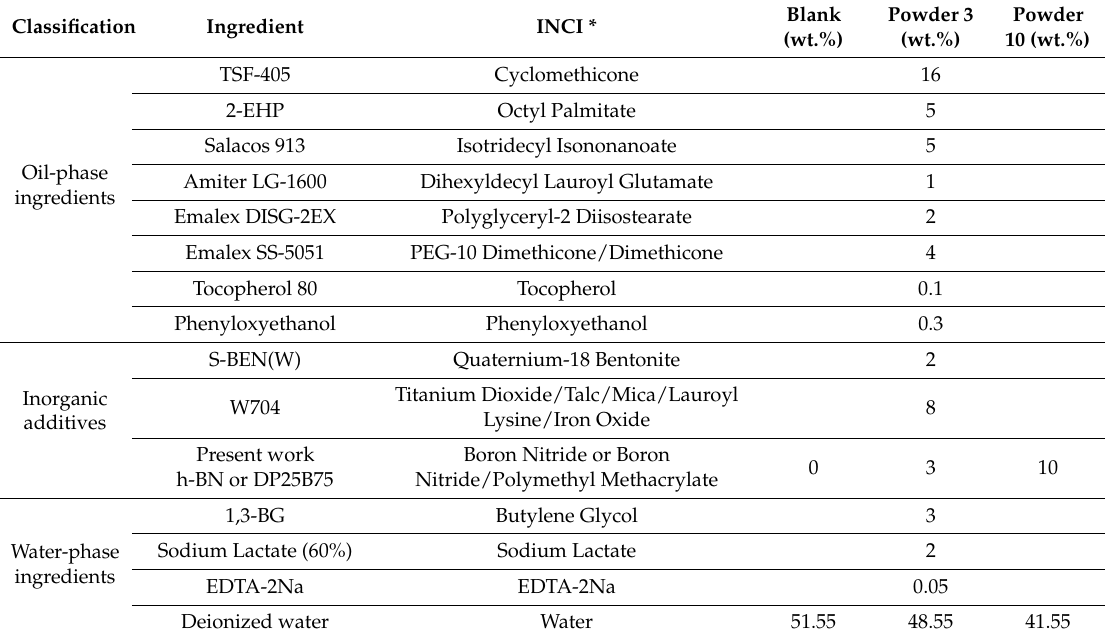
Table 1. Ingredients of blank and powder-added BB